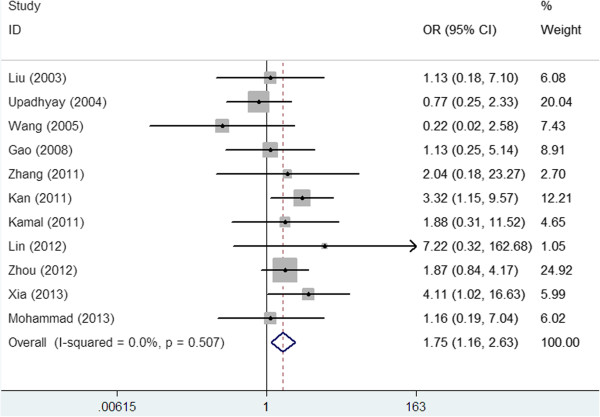
Forest plots of meta-analysis of the risk of AVN. Closed reduction internal fixation vs. open reduction internal fixation.